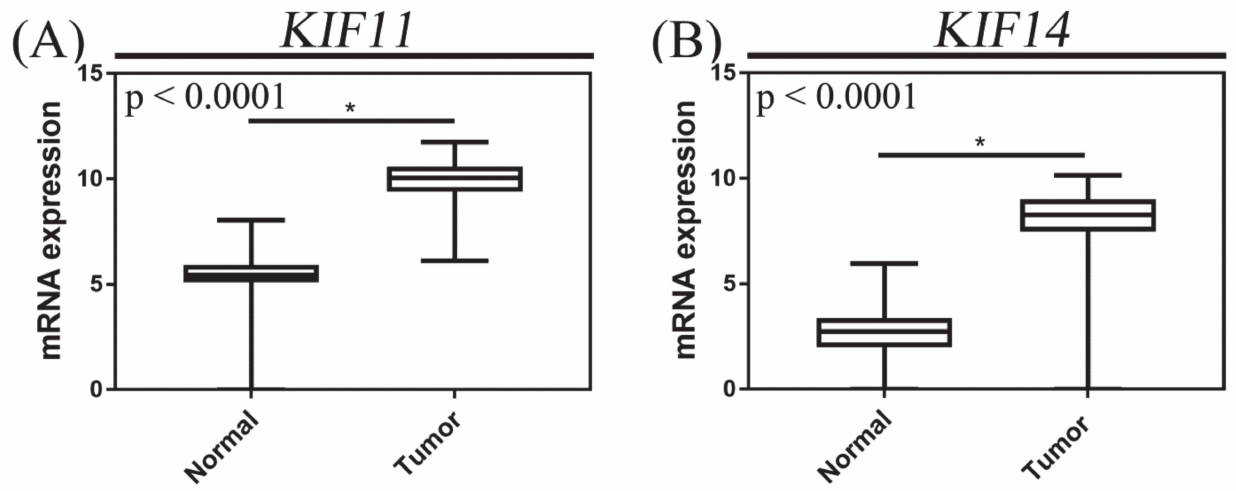
Figure 4. mRNA expression of KIF11 ( A ) and KIF14 ( B ) in pancreatic adenocarcinoma. mRNA expression data were retrieved from the Cancer Genome Atlas (TCGA); the X axis of the plot represents normal vs. cancer tissue, and the Y axis represents normalized expression of mRNAs. The top and bottom of the error bars represent the maximum and minimum values of data, respectively. The asterisk indicates statistical significance (* p < 0.05, Mann–Whitney